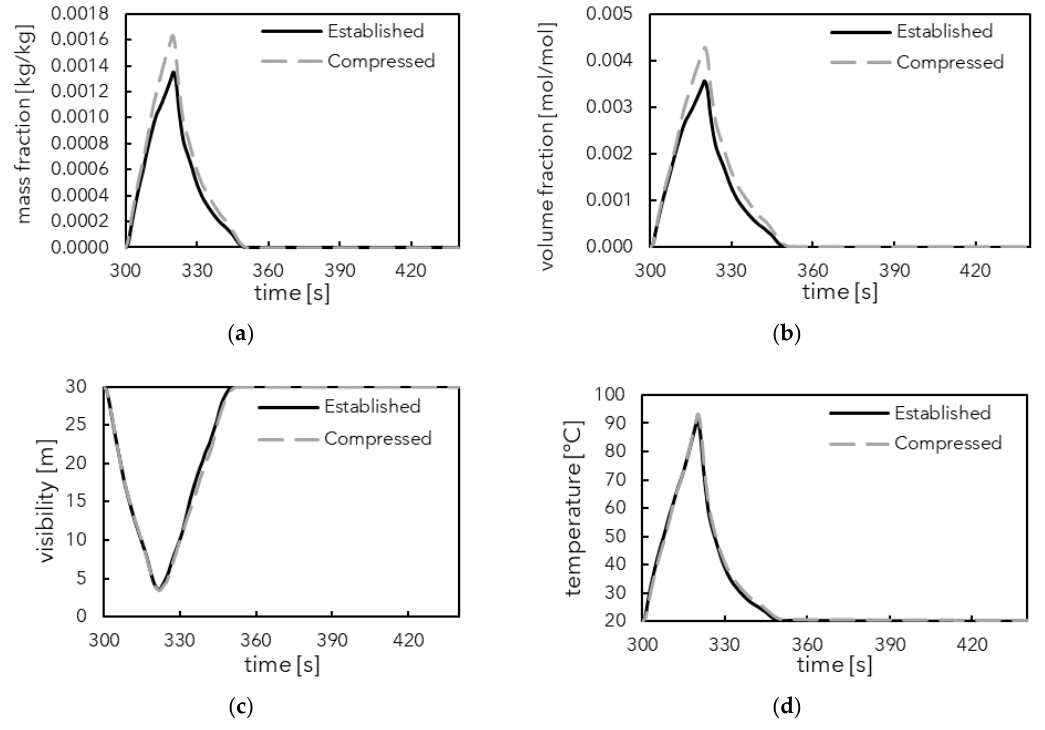
Figure 7. Results for means of escape phase, spatially-averaged for the full corridor volume: ( a ) soot mass fraction; ( b ) soot volume fraction; ( c ) visibility; and ( d ) temperature.